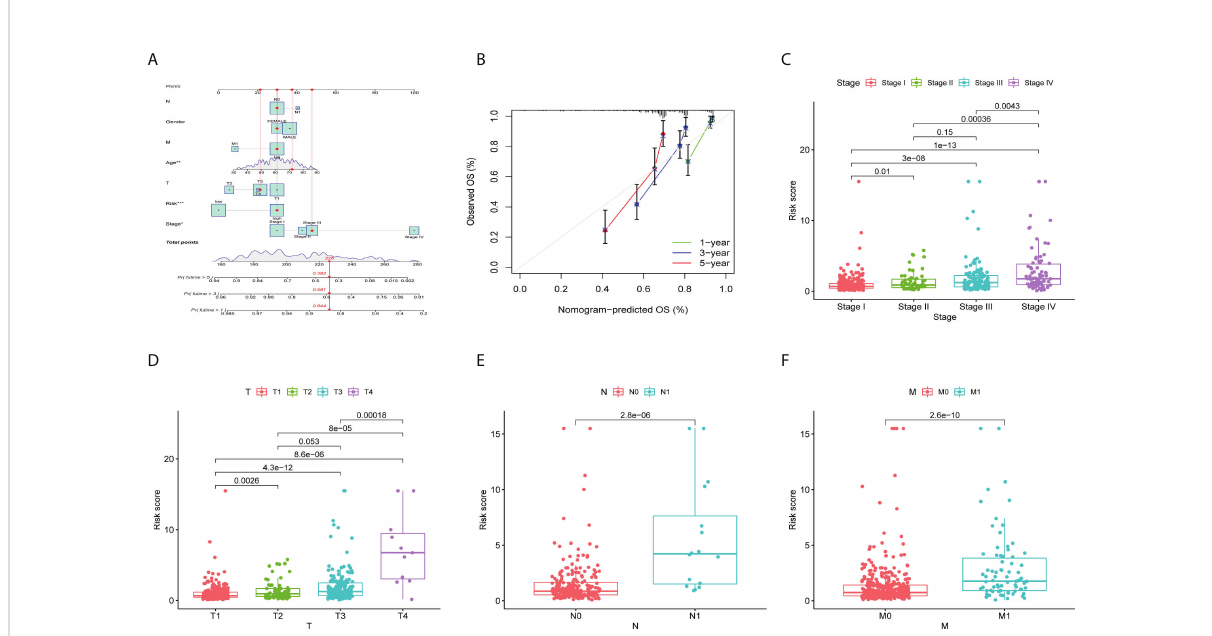
FIGURE 4 Validation of prognostic features in ccRCC. (A) Construction of a nomogram combining the risk prognostic signature and clinical features for prediction of OS. (B) Calibration plots display the actual and nomogram-predicted probability of the 1-, 3- and 5-year OS periods. (C-F) The box plot depicts the relationship between risk score and clinicopathology. (C) N stage, (D) M stage, (E) clinical stage, and (F) T stage. * P < 0.05; ** P < 0.01; *** P < 0.001.